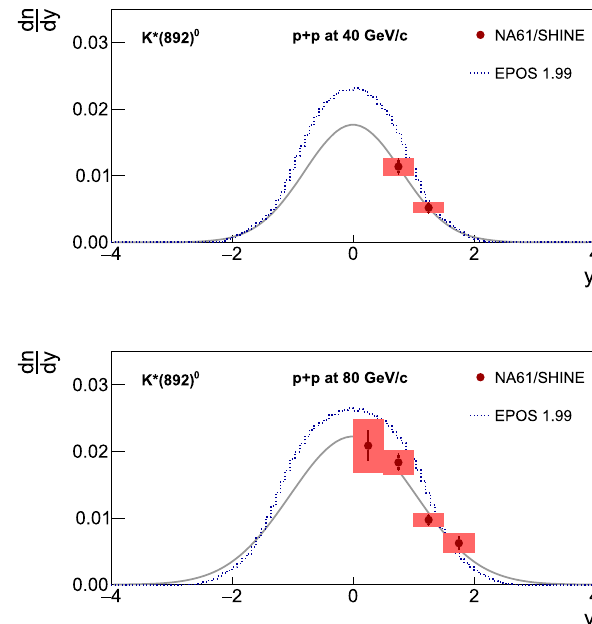
Fig. 11 The comparison of K ∗ ( 892 ) 0 rapidity distributions from NA61/SHINE (points) and the Epos1.99 model (dotted lines). Results for inelastic p+p collisions at 40 GeV / c (top) and 80 GeV / c (bottom). The fitted Gaussian functions to NA61/SHINE points (gray solid lines) are given by Eq. (13)